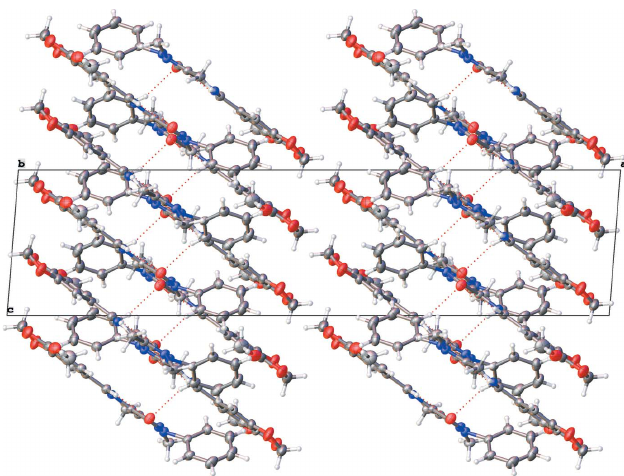
Figure 3 Packing diagram of I as viewed down the b -axis direction. Dashed red lines indicate hydrogen-bonding